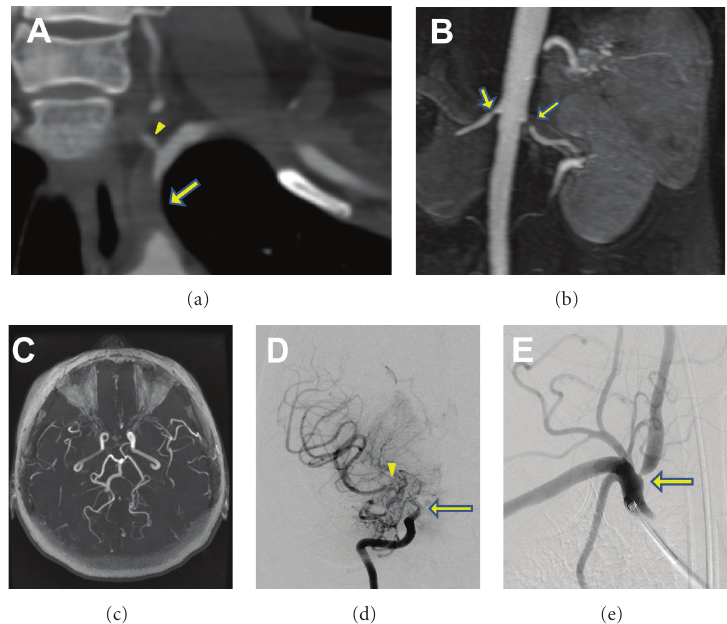
Figure 1: Multimodality imaging demonstrating stenoocclusive disease of intracranial and extracranial arteries. (a) CT angiogram chest demonstrating complete occlusion of left subclavian artery (arrow) with distal filling from left VA (arrowhead). Remainder of VA is out of plane of view, but patent distally. (b) MR Angiogram of abdomen demonstrating bilateral renal artery stenoses (arrows). (c) Time-of-flight MR angiogram of head showing absence of bilateral MCA vessels and decreased flow of both ICAs. The posterior circulation is relatively plethoric. (d) Conventional angiogram of the right ICA (AP projection) showing typical moyamoya appearance of intracranial occlusion of supraclinoid ICA (arrow) with reconstitution of the MCA via multiple small moyamoya collaterals (arrowhead). (e) Right subclavian digital subtraction angiogram demonstrating high-grade ( > 70%) right VA stenosis